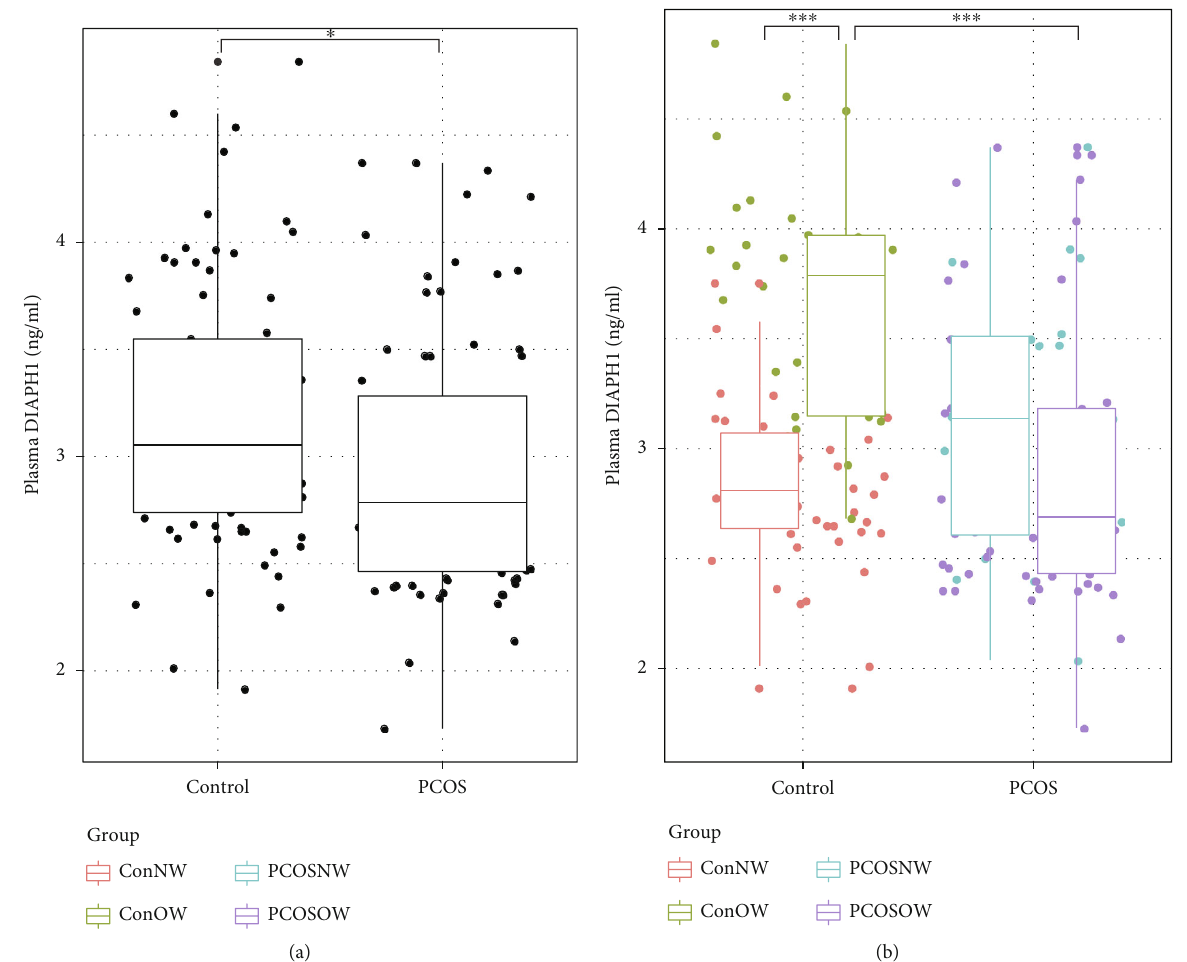
Figure 1: Plasma DIAPH1 levels in PCOS and healthy subjects. (a) The DIAPH1 levels in healthy controls and PCOS subjects, control n = 77 , PCOS n = 75 . (b) DIAPH1 levels in subjects divided into normal-weight and overweight subgroups, Con-NW n = 47 ; Con-OW n = 19 ; PCOS-NW n = 30 ; PCOS-OW n = 56 . Data are presented as interquartile ranges (25 – 75%). The Mann – Whitney U test was performed to compare variables between the two groups. The Kruskal-Wallis test followed by pairwise comparisons using the BWS all- pairs test was performed for the four subgroups. ∗ P < 0 : 05 , ∗∗ P < 0 : 01 , ∗∗∗ P < 0 : 001